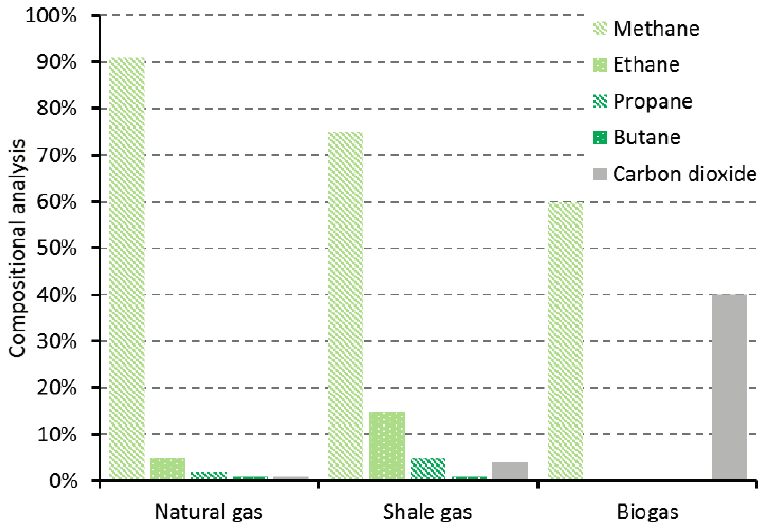
Figure 12. The composition of methane rich gases